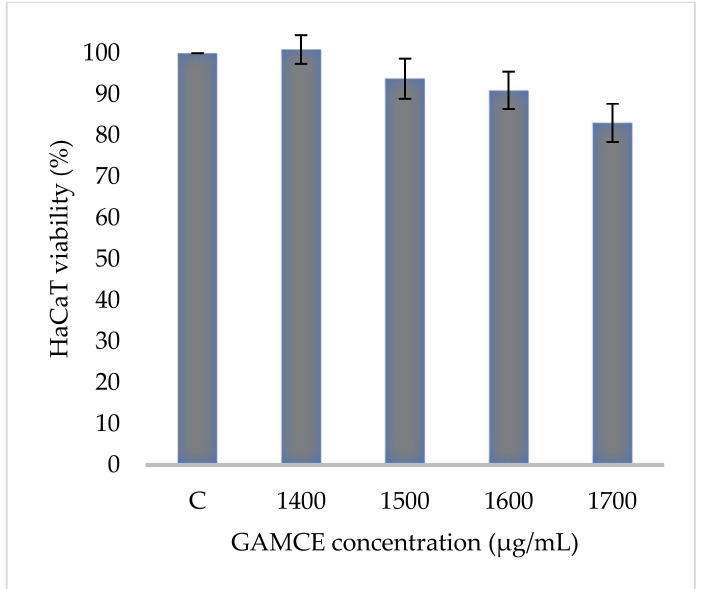
Figure 3. HaCaT cells, control group (C = 100% viability) was not treated at all; experimental groups were treated with different concentrations (1400, 1500, 1600, and 1700 µ g/mL) of GAMCE for 24 h. The result did not show significant difference. The data are shown as Mean ± SE. Mean significant difference compared to control.